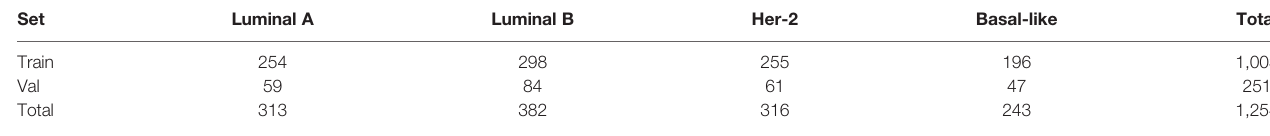
TABLE 1 | Distribution of each molecular subtyping in the BCMT